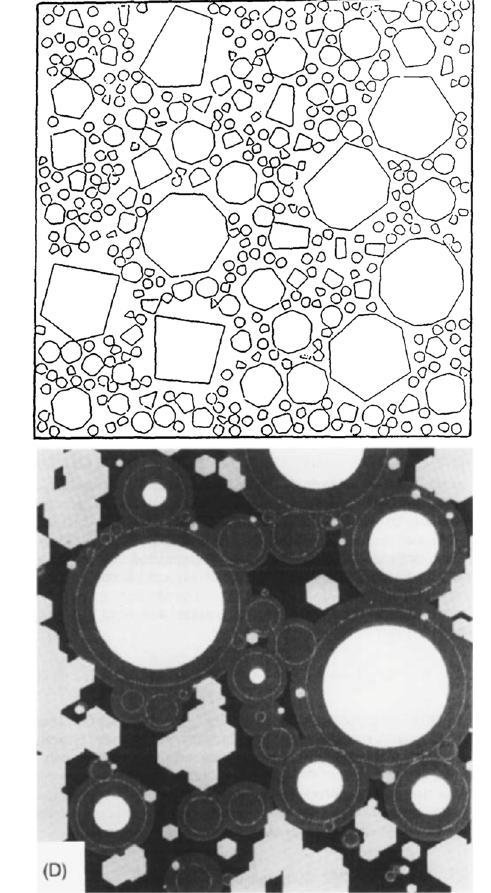
Figure 1. Simulated meso ‐ structure of a concrete from Sadouki 1987 [11] showing spherical aggregates in a matrix of mortar (top) and simulated microstructure of a cement paste showing hydration products depositing over spherical cement particles and in the pores from Jennings and Johnson [12] (reproduced with permission)